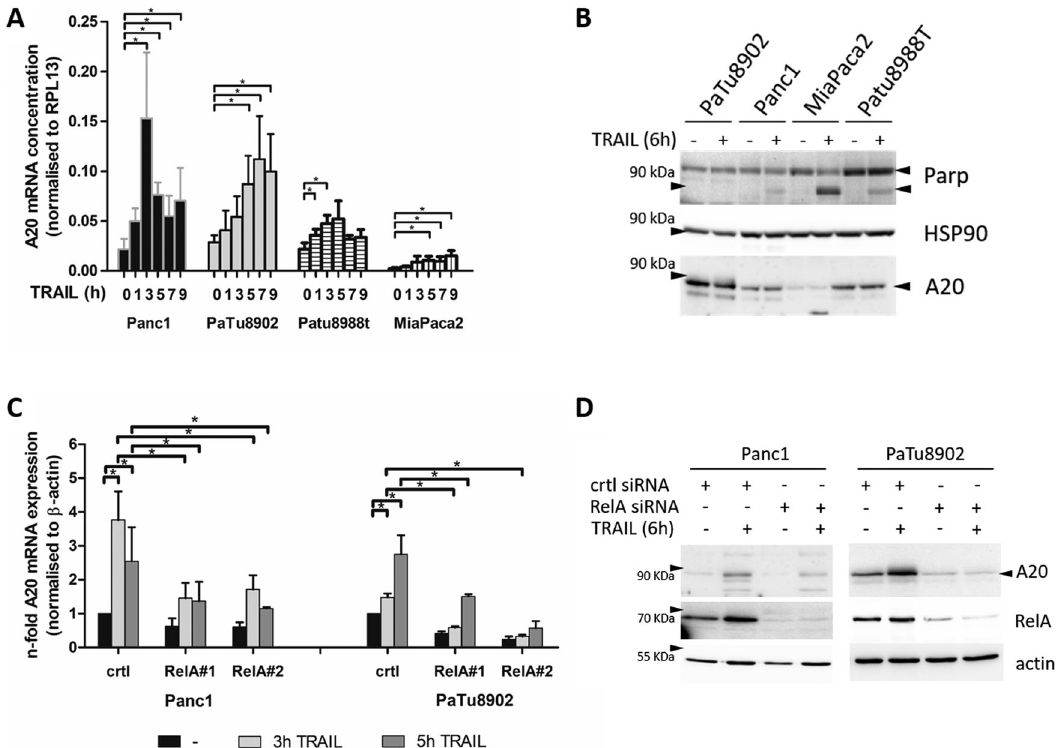
Fig. 2 RelA-dependent A20 expression correlates with chemoresistance of PDAC cells. A Panc1, Patu8988t, PaTu8902, and MiaPaca2 cells were left untreated or treated with TRAIL for indicated periods. Isolated total RNA was submitted to reversed transcription and A20 mRNA was measured by real-time PCR. An external standard curve was applied. A20 mRNA expression was related to RPL13 gene expression. The mean values of 5 independent experiments performed in duplicates ± S.D. are depicted, * P -values <0.05. B Cells were treated with TRAIL for 6 h and whole-cell lysates were analyzed with indicated antibodies. HSP90 was used as a loading control, n = 5. (C + D) Resistant PDAC cells were treated with indicated siRNAs and left untreated or with TRAIL for 3 h or 5 h C or 6 h D . C Isolated total RNA was reversed transcribed and analyzed by real-time PCR for A20 mRNA expression and normalized to housekeeper gene expression. Depicted are the mean values of 5 independent experiments performed in duplicates ± SD * P -values < 0.05. D western blot analysis with total lysates was done with indicated antibodies and β -actin as a loading control, n =